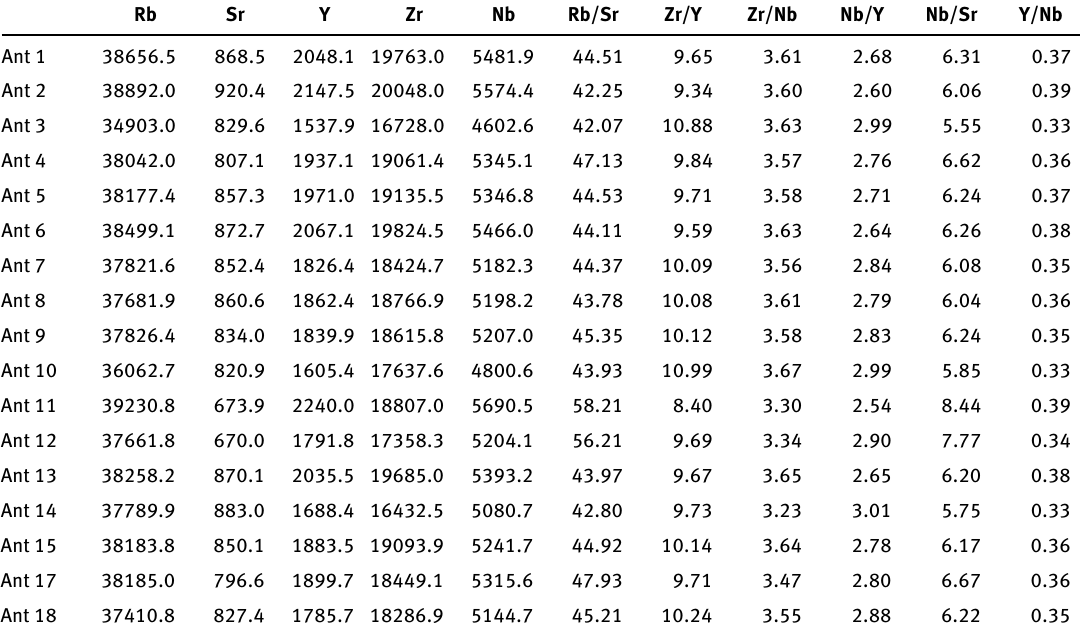
Table 5. X-ray emission and characterizing ratio of some contiguous trace elements of Antiparos obsidian. The X-rays intensity values. expressed as counts per second. are background and interference